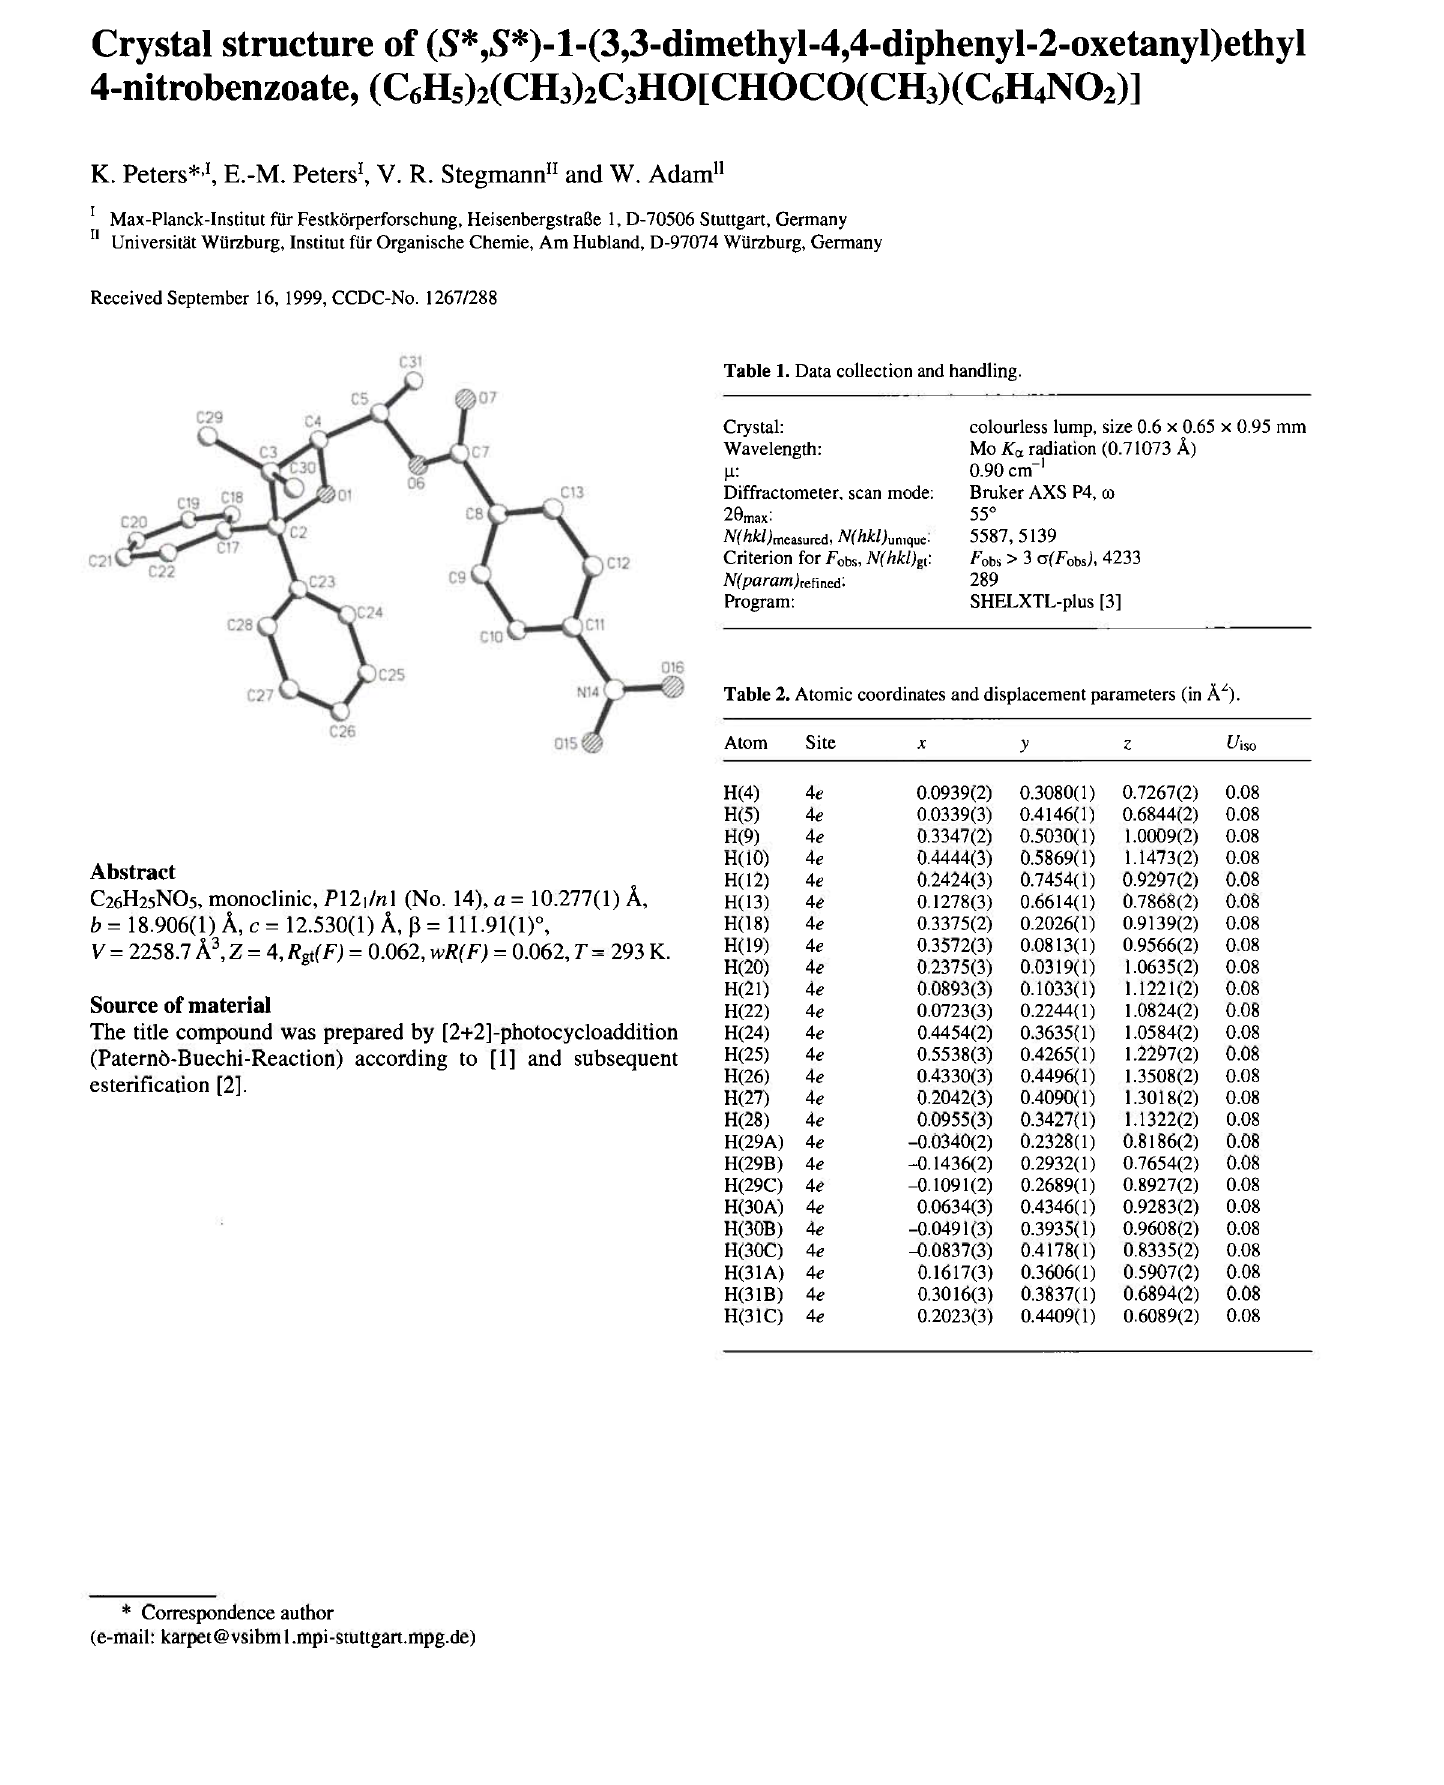
Table 1. Data collection and handling.